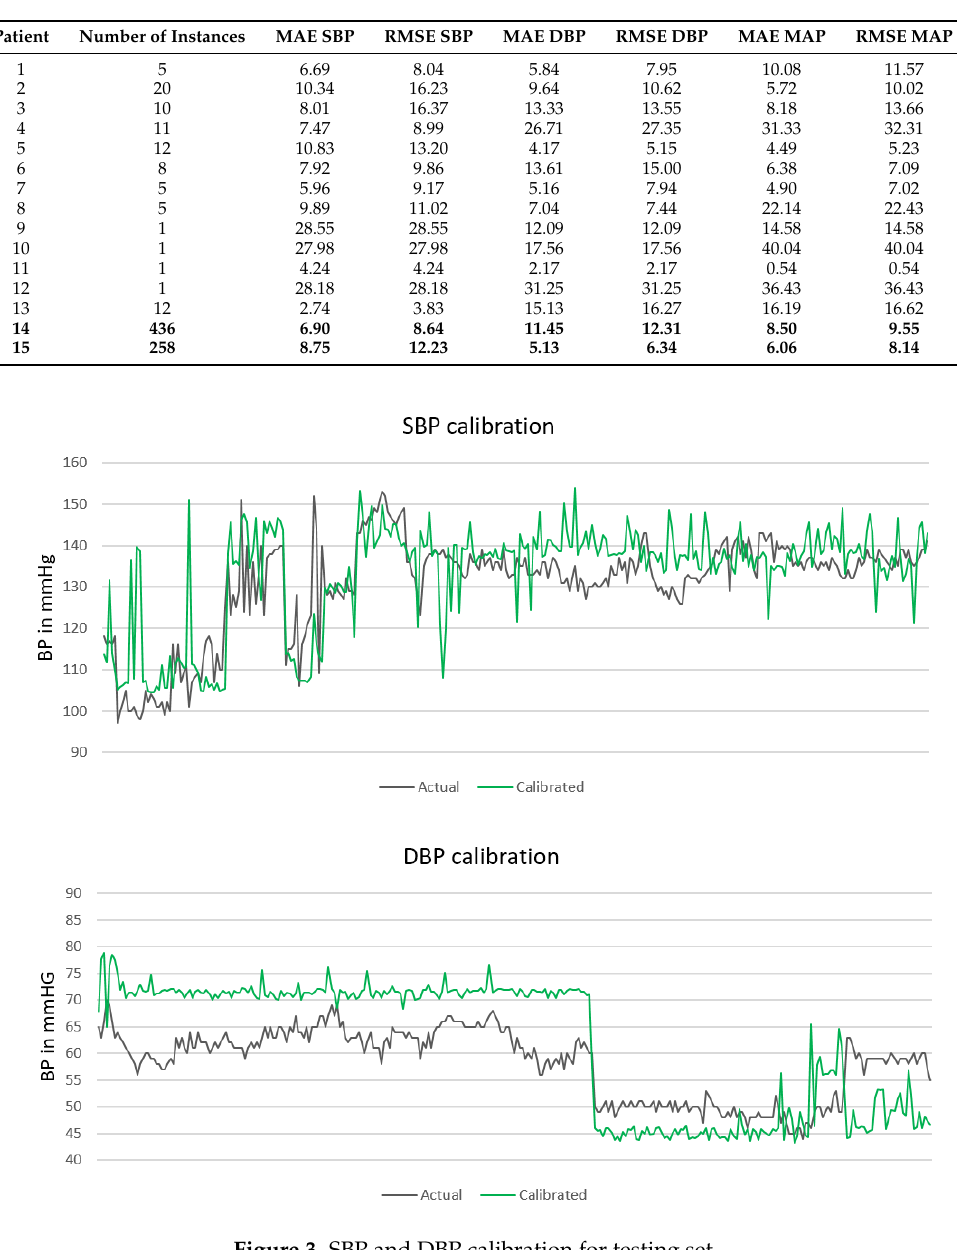
Table 8. Calibrated MAE and RMSE evaluation for SBP, DBP and MAP.